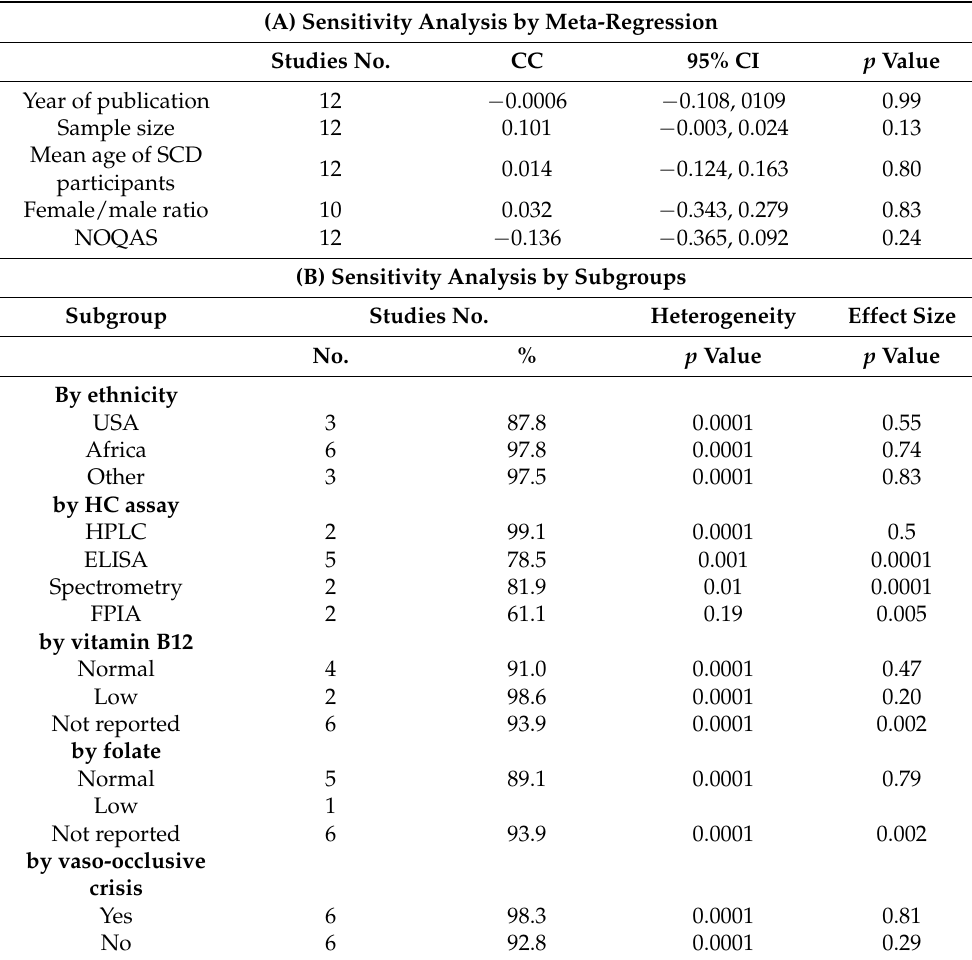
Table 4. Sensitivity analysis in the adult sickle cell disease/control comparison for plasma homocysteine. (A) Sensitivity Analysis by Meta-Regression Studies